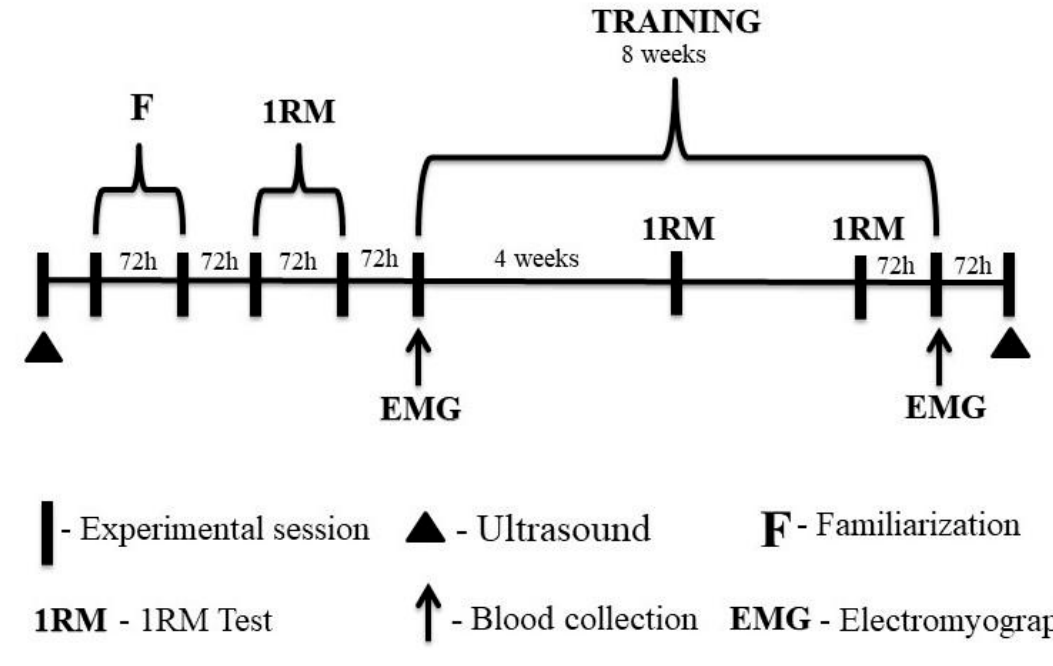
Figure 2. Experimental design of the study.